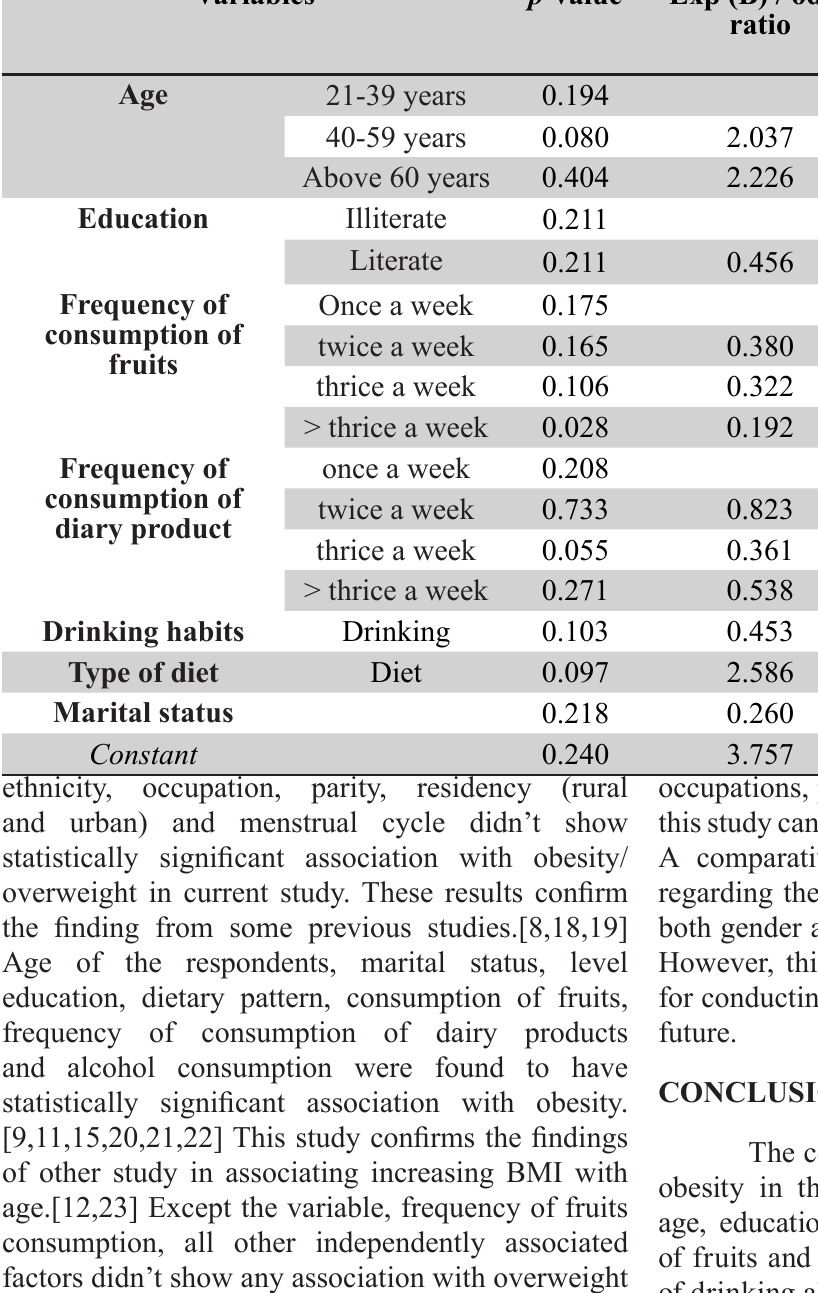
Table 4: Risk factors associated with obesity (N=160) Variables